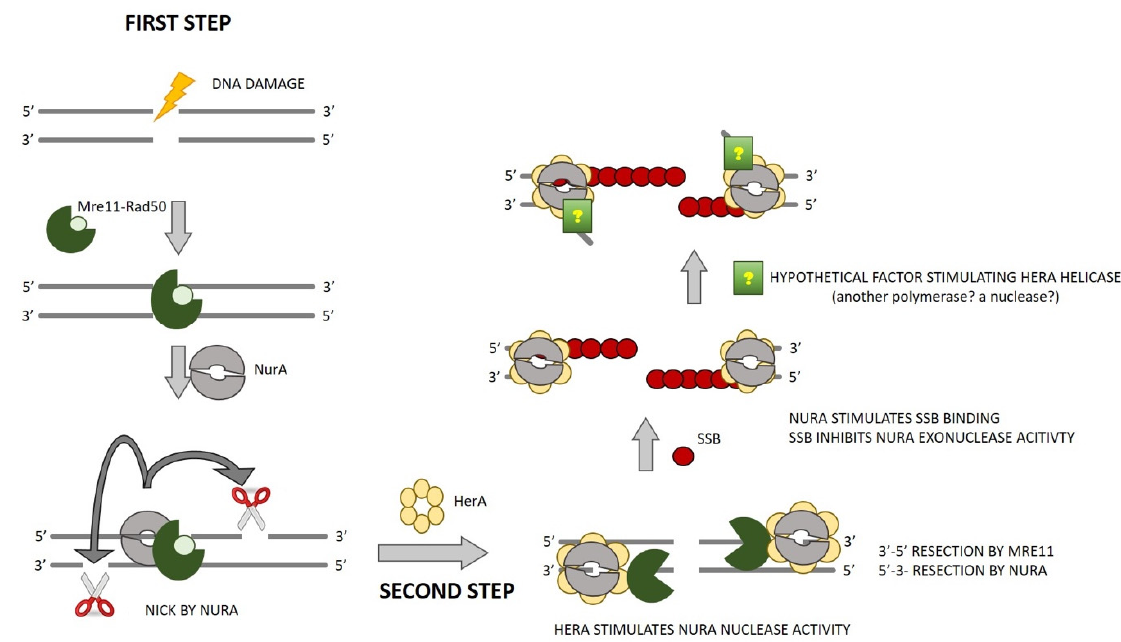
Figure 9. Two-step end resection model in S. solfataricus . First step: Mre11/Rad50 (dark and light green, respectively) complex recognizes and binds the DSB. NurA (grey dimer) nicks the DNA strand that possesses a free 5 ′ end giving rise to a downstream step of resection. Second step: a 3 ′ ssDNA is generated in a bidirectional manner using the 3 ′ -5 ′ and 5 ′ -3 ′ exonuclease activities of MRE11 and NurA, respectively, together with HerA (yellow hexamer) that stimulates NurA exonuclease activity. SSB (red circle) is now rapidly recruited to the DNA, binds to ssDNA generated by the combined action of NurA and Mer11 and forms a nucleoprotein filament that inhibits NurA exonuclease activity. At this step, another protein has to be involved (such as polymerase, nuclease or recombinase, represented as a green square with a yellow question mark) in order to enhance HerA helicase activity and the subsequent recombination process.